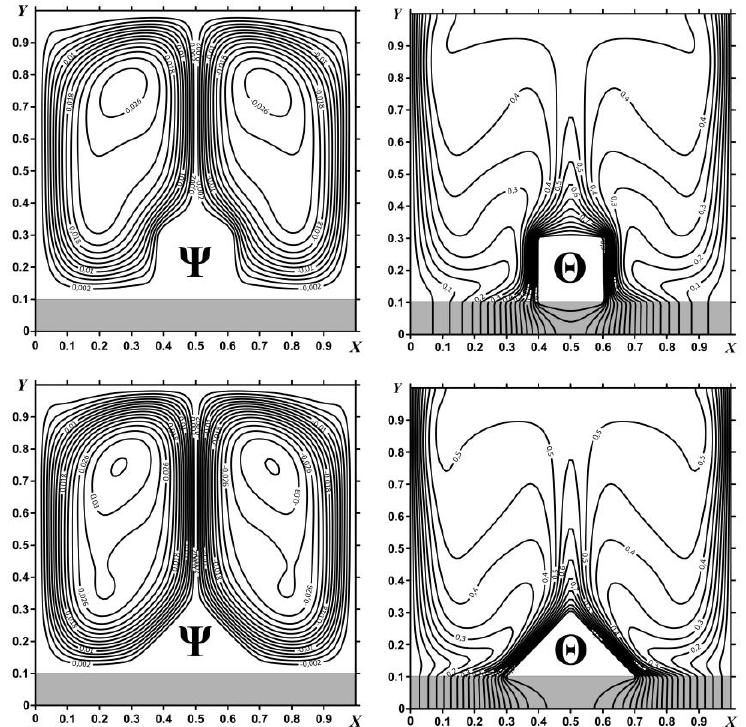
Figure 5. Streamlines Ψ and isotherms Θ at Ra = 10 6 , k = 631.8 (steel material for the bottom wall) and different shapes of heater.